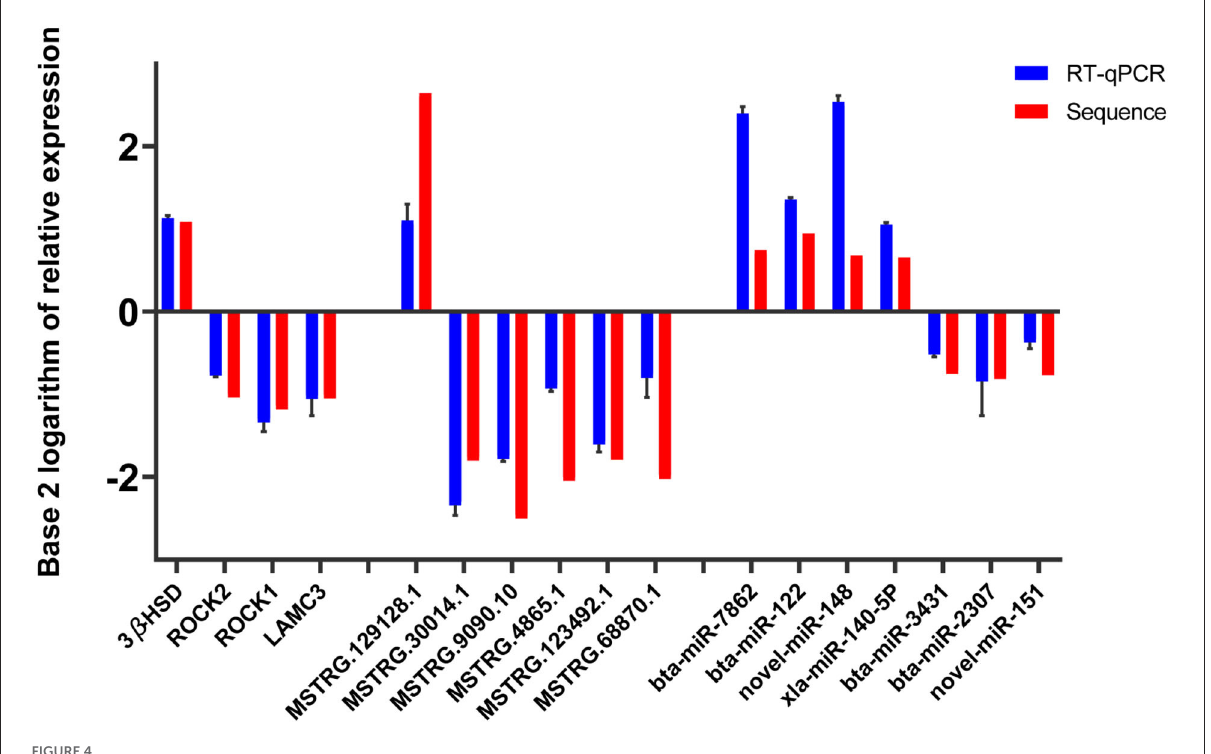
FIGURE4 Validation of